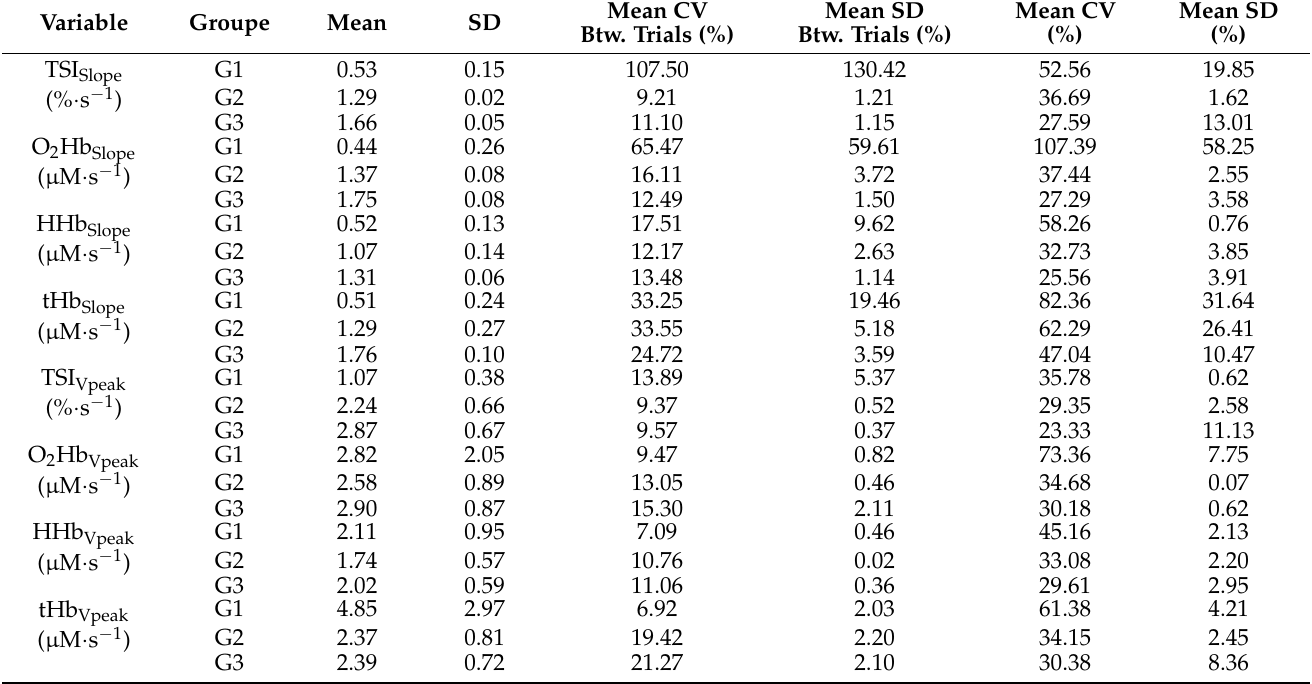
Table 6. Reoxygenation rate within-participant